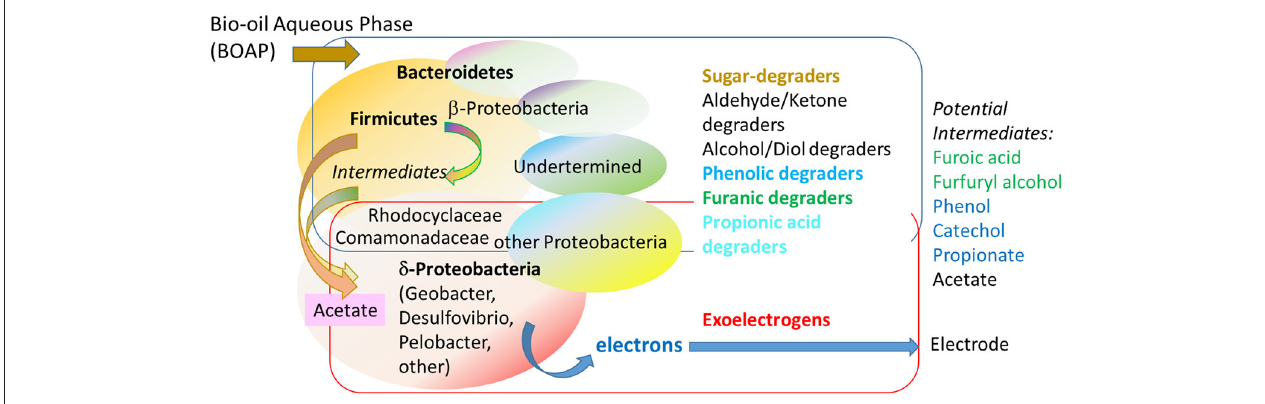
FIGURE 5 | Biochemical interactions within anode chamber leading to electroactivity via microbial syntrophy and division of labor transforming BOAP into electrons. A fermentative population with diverse functionalities is necessary to convert the sugars and other degradation products in BOAP to intermediates, which are ultimately converted to electrons by exoelectrogens. Determination of the details of the interactions between various members of the complex consortium require further research and sophisticated techniques such as omics to be employed for identification of the role of individual